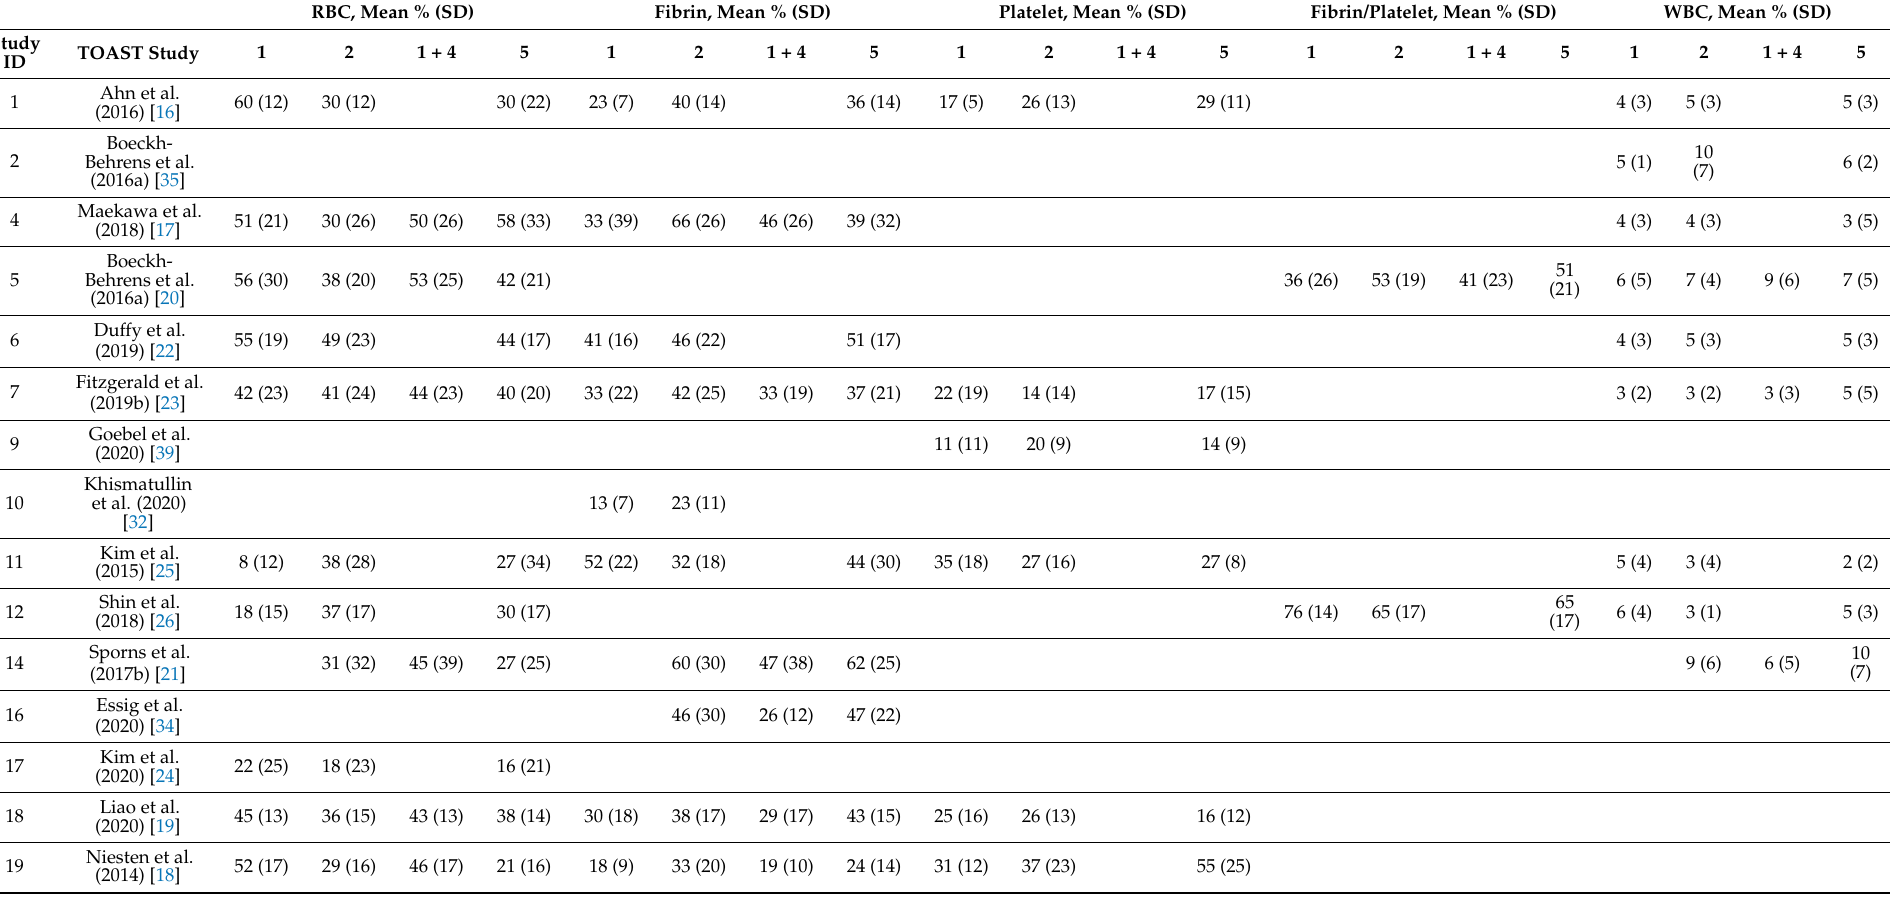
Table 2. Clot Component Fractions according to Aetiology in Included